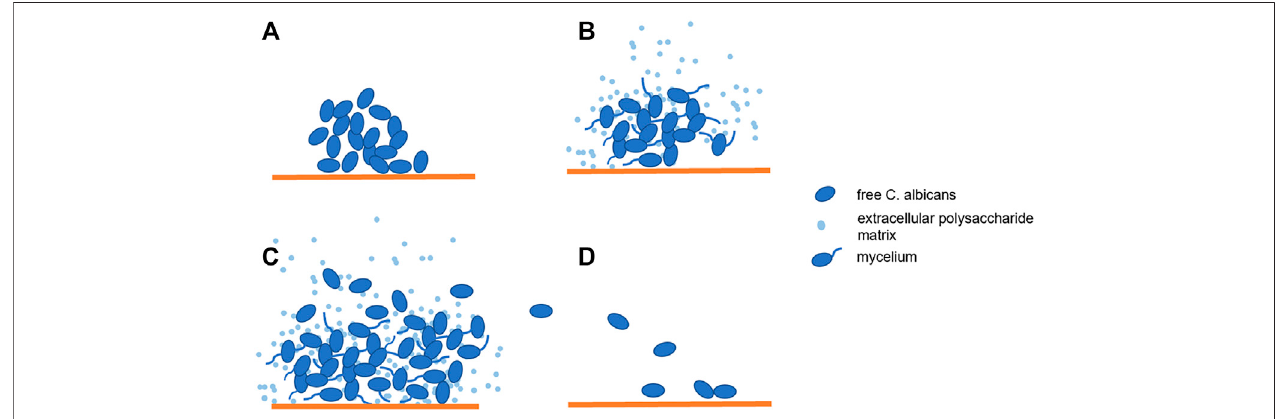
FIGURE 1 | Bio fi lm Formation: (A) . Candida albicans adhere to the substrate; (B,C) . The cells proliferated and formed mycelia while extracellular polysaccharide matrix accumulated; (D) . The beginning of new bio fi lm formation.